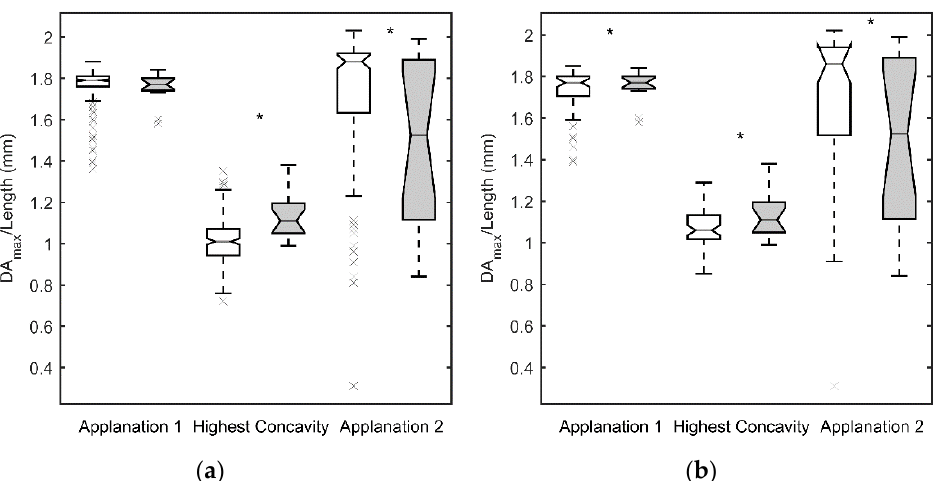
Figure 2. Maximum deformation amplitude (DA max ) at highest concavity and length applanation at first and second measurement for the SCKC (grey) and control groups (white). Symbols, as in Figure 1. ( a ) whole control group, ( b ) IOP and CCT matched control group.